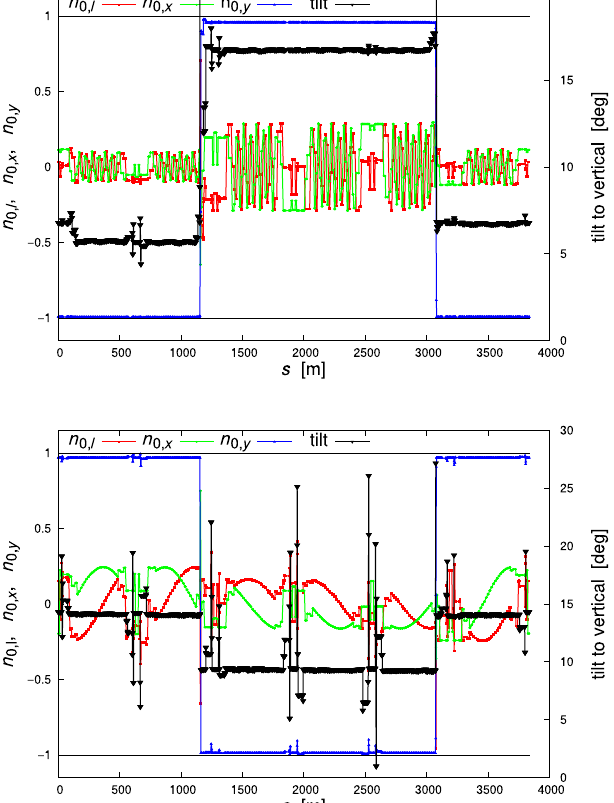
FIG. 19. Energy dependence of ⃗ n 0 components (left axis) and ⃗ n 0 angle to the y axis (right axis) at STAR (top) and at p-C polarimeter (bottom); n denotes the modulus of the projection xy of ⃗ n 0 in the ( x; y ) plane, which is the vector actually measured at the p-C polarimeter [14]. The right vertical bar at G γ ¼ 487 materializes the region of nominal operation with full snakes. The left vertical bar at E ¼ 254 . 2 GeV was the optimal energy found from measurements, for operation with partial snake during RHIC Run 22, which this graph shows to be close to the expected energy value for a zero-tilt to vertical. Snake field maps are used for this energy scan.